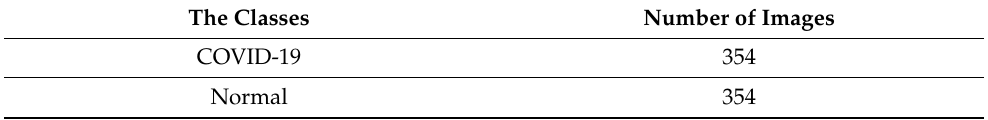
Table 1. Numerical description of the prepared dataset for a binary